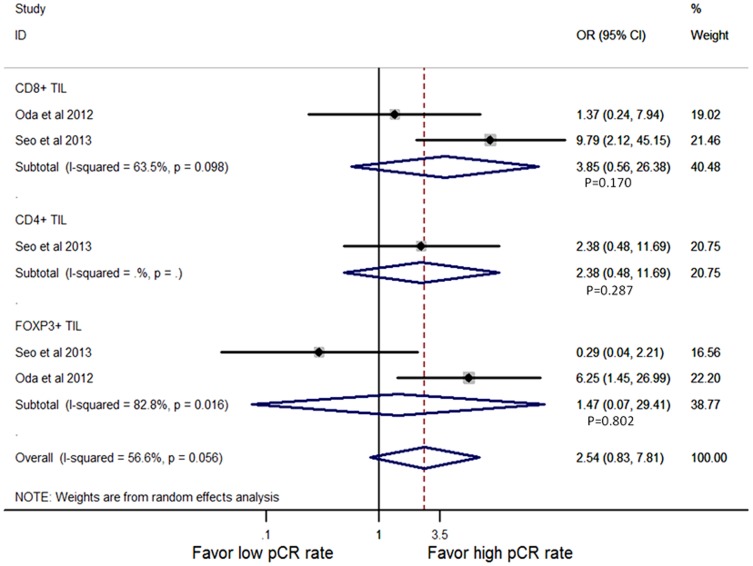
Forest plots from the random-effect meta-analysis of the efficacy of TIL subset on NAC response in pre-treatment biopsy in multivariate way.The width of horizontal line represents 95% CI of the individual studies, and the grey boxes represent the weight of each study. The diamond represents the overall summary estimate. The unbroken vertical line was set at the null value (HR = 1.0).